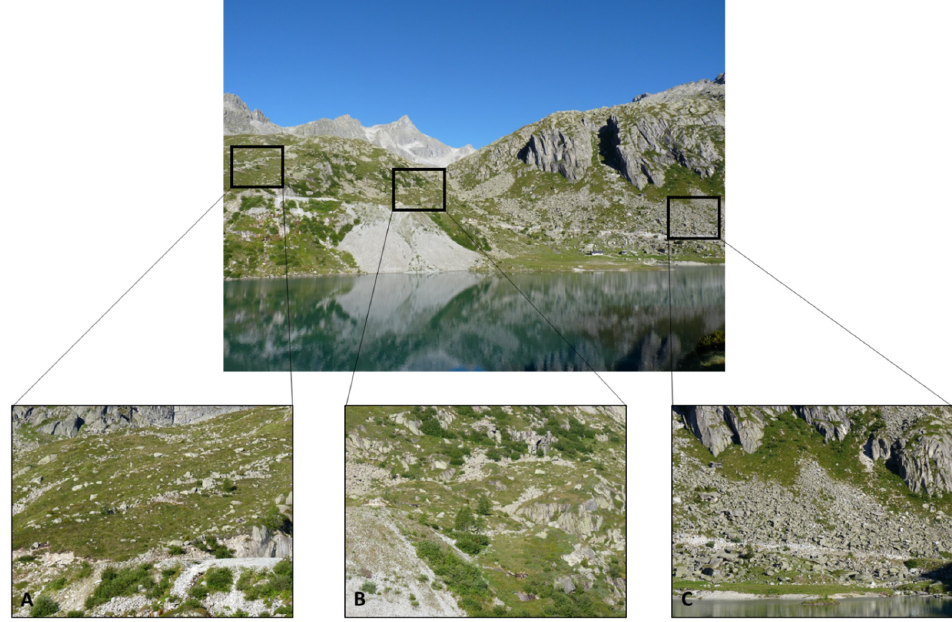
Figure 1. The study area and the three sampling sites (from left to right: grassland ( A ), heath ( B ), and rocky scree ( C )).